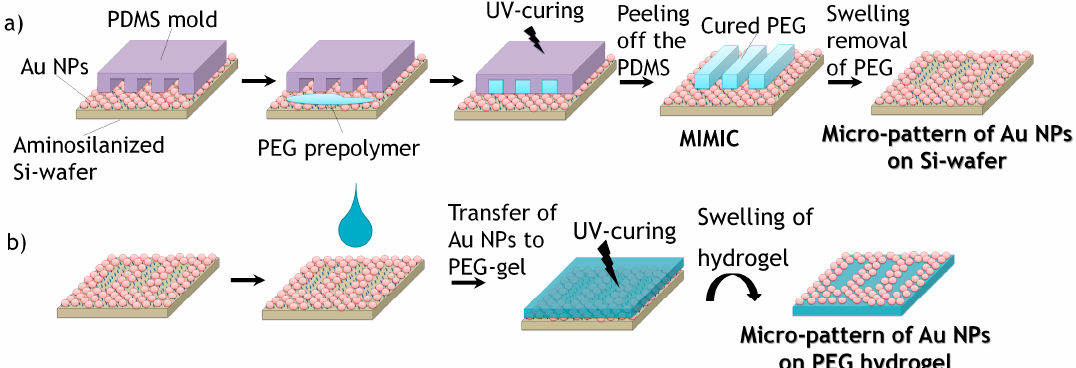
Figure 2. Schematic process of Wet Micro-Contact Deprinting (wet µ–CdP): ( a ) micro-patterning of gold nanoparticles (Au NPs) on silicon wafer via Micro-Molding in Capillaries (MIMIC) process; ( b ) transfer micro-pattern of Au NPs onto poly(ethylene glycol) (PEG)-hydrogel.